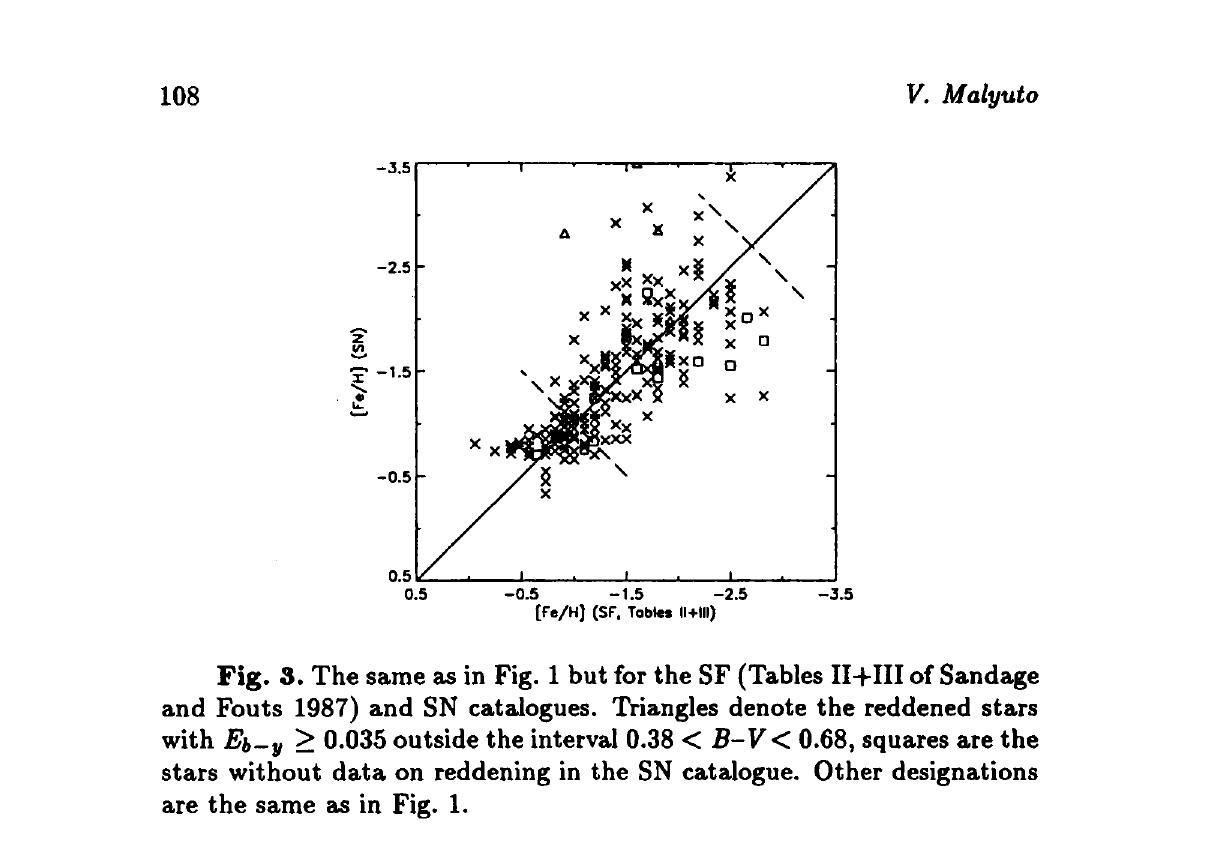
Fig. 3. The same as in Fig. 1 but for the SF (Tables II+III of Sandage and Fouts 1987) and SN catalogues. Triangles denote the reddened stars with Eh-y > 0.035 outside the interval 0.38 < B-V< 0.68, squares are the stars without data on reddening in the SN catalogue. Other designations are the same as in Fig. 1.